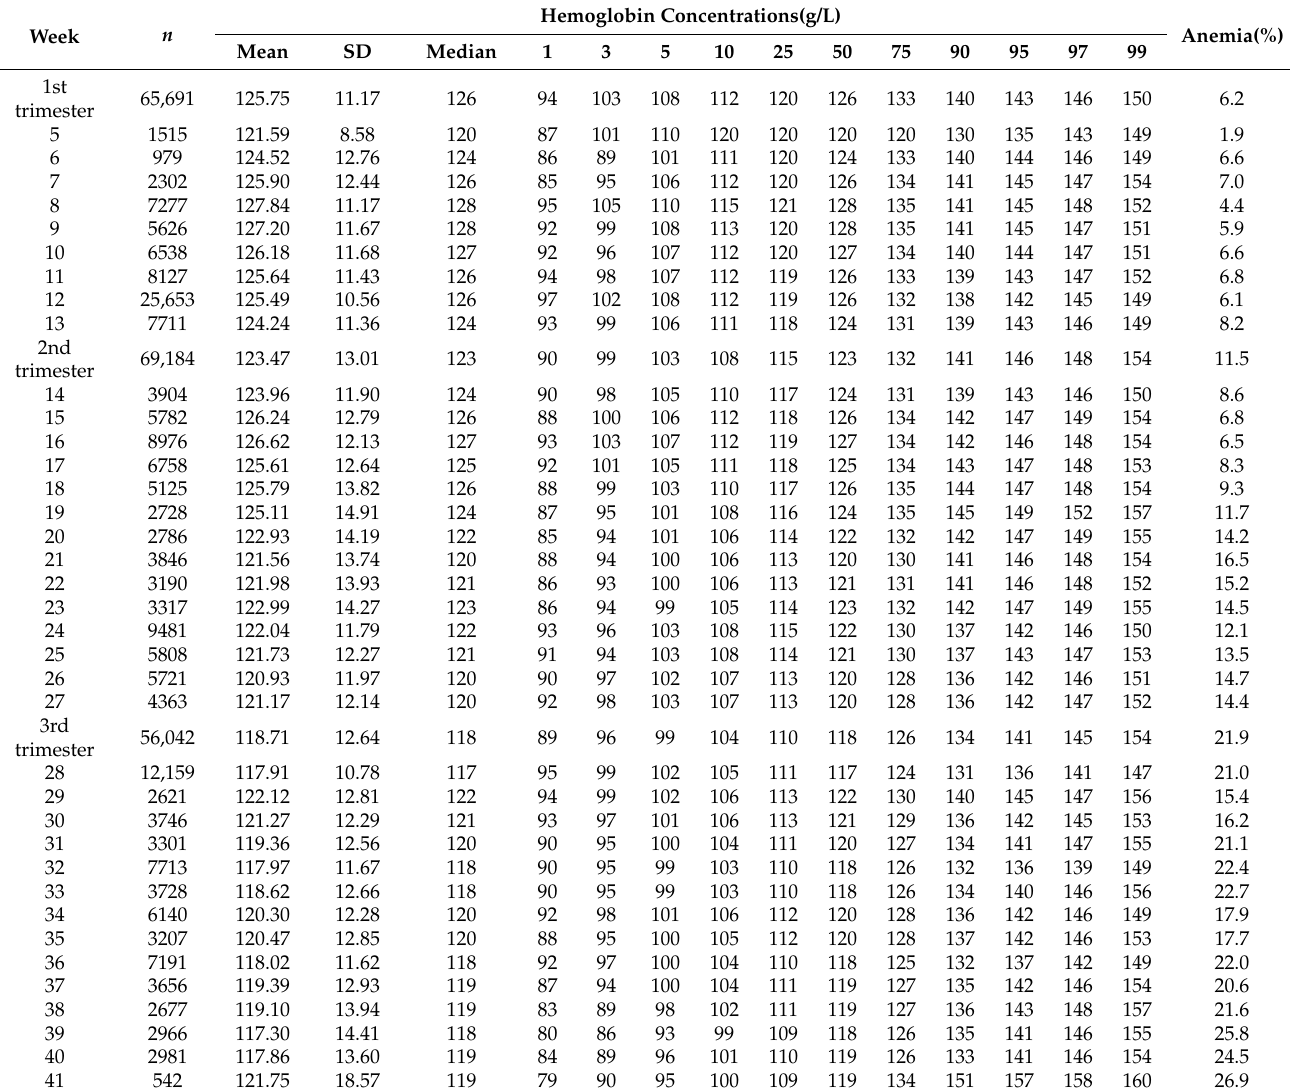
Table 2. Hemoglobin concentrations (g/L) and the prevalence of anemia (%) according to gestational